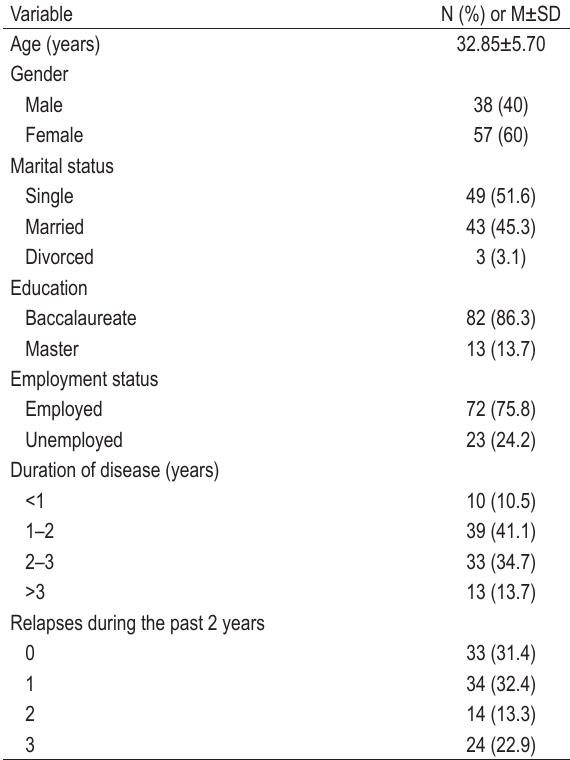
TABLE 1. Sociodemographic characteristics of participants